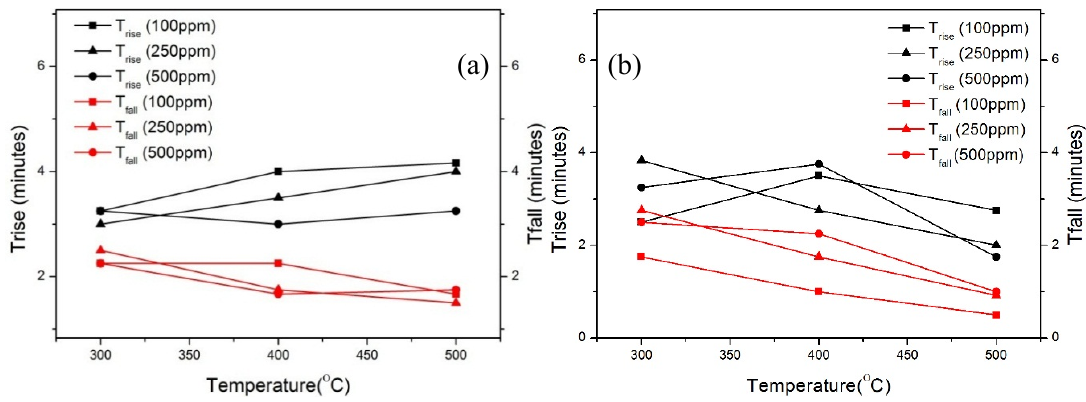
Figure 11. Response time and recovery time of the TiO 2 NWs in the temperature range of 300–500 °C to ( a ) ethanol ( b ) hydrogen.